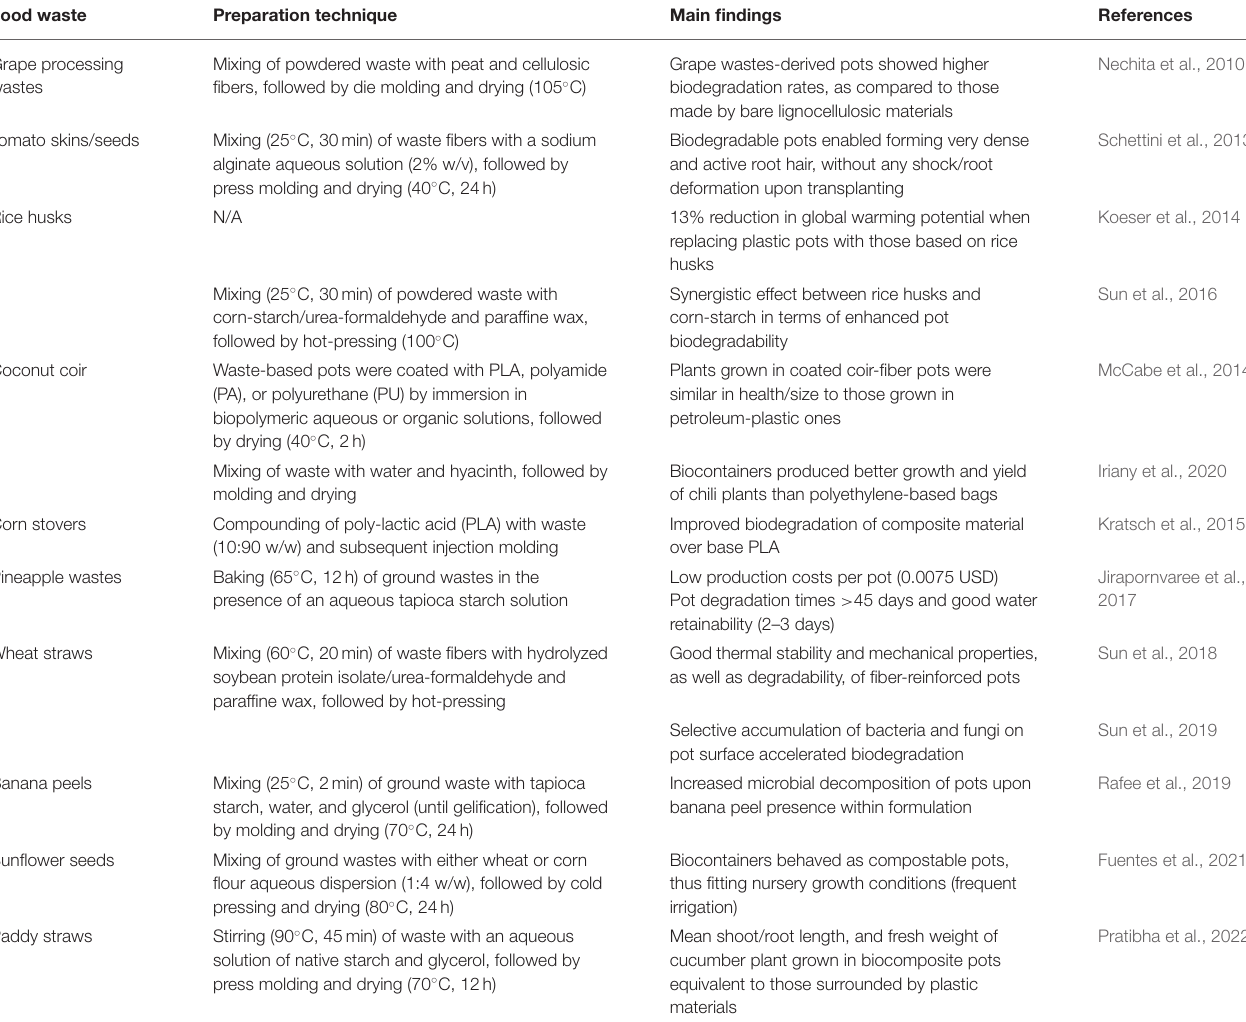
TABLE 1 | Summary of the main preparation techniques adopted to produce biodegradable pots from food wastes. Food